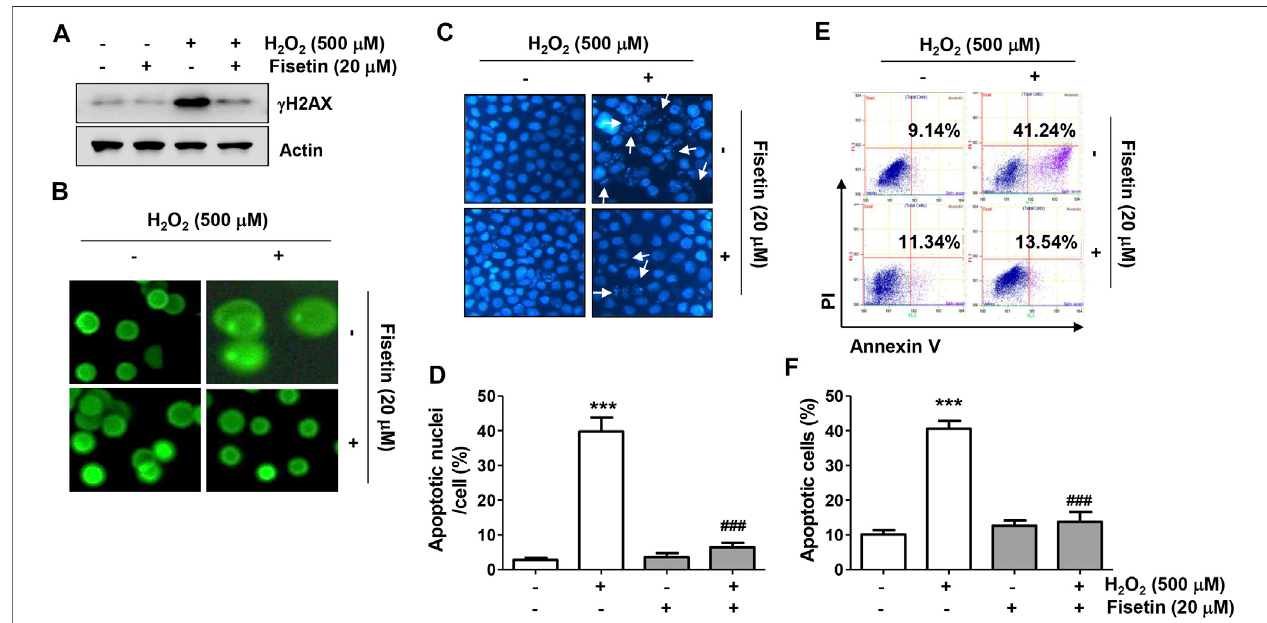
FIGURE 3 | Fisetin protected ARPE-19 cells against H 2 O 2 -induced DNA damage and apoptosis. Cells were stimulated with or without 20 μ M fi setin for 1 h and then treated with 500 μ M H 2 O 2 for another 24 h. (A) Levels of total p- γ H2AX and actin were determined by immunoblotting using cell lysates. (B) Comet assay was performed to analyze DNA damage. Representative immuno fl uorescence microscopic images are shown. H 2 O 2 -induced increases in p- γ H2AX expression and comet tail formation were apparently alleviated pretreatment of fi setin. (C,D) Cells were stained with DAPI for nuclear morphological observation under a fl uorescence microscopefordetectionofapoptosis. (C) RepresentativeimagesofDAPI-stainednucleiareshown. (D) Quanti fi cationresultsofnucleiwithapoptotic cellsareshown in